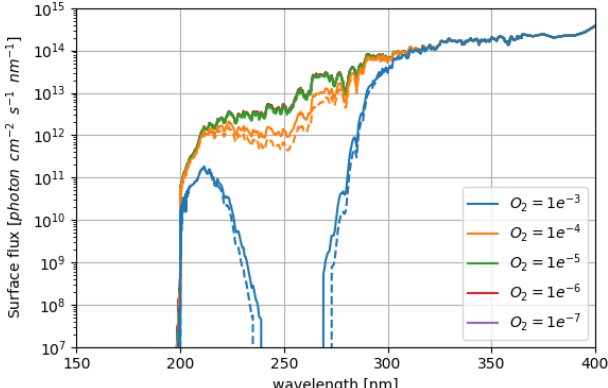
Figure 8. Stellar flux reaching the surface for several surface oxy- gen levels and surface methane of 10 − 4 . Results of the 3D model surface and annual average (solid) as well as the 1D model